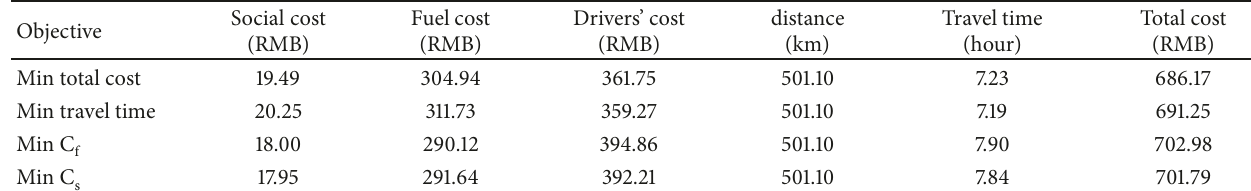
Table 2: Comparison among solutions with different optimization